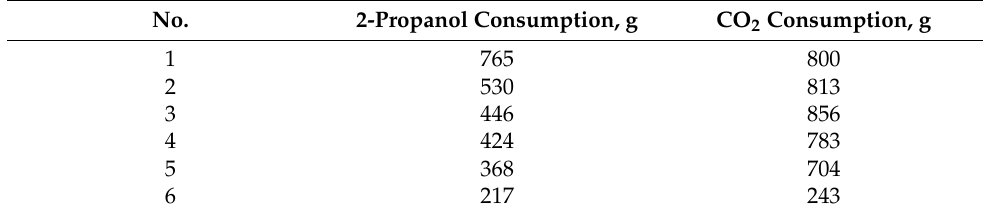
Table 6. Calculated values of components consumption during the solvent exchange process. No.